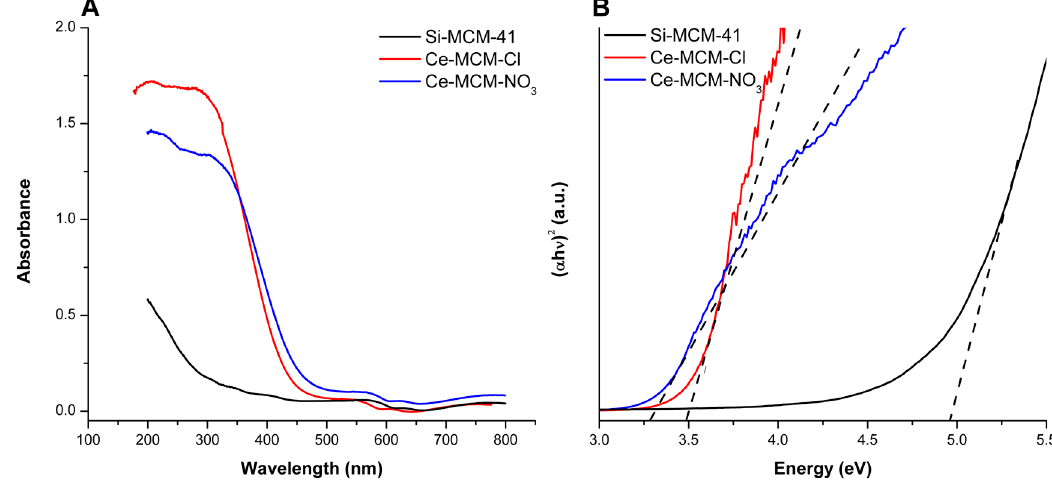
Figure 6. Absorption spectra ( A ) and Davis-Mott plots ( B ) for the calcined MCM-41